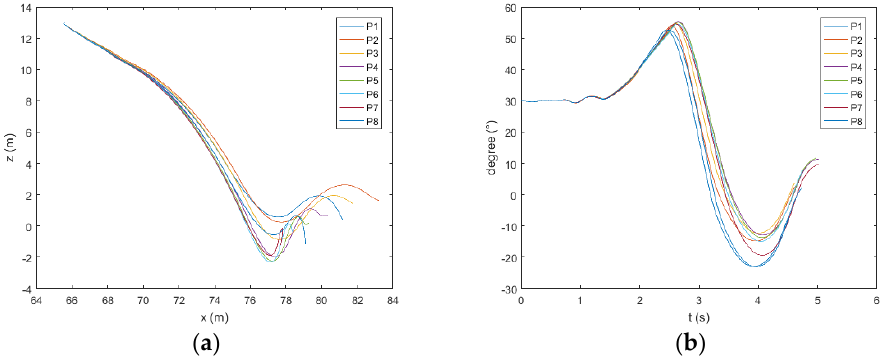
Figure 15. Trajectory ( a ) and pitch ( b ) of the lifeboat freefall when the wave height is 3 m.